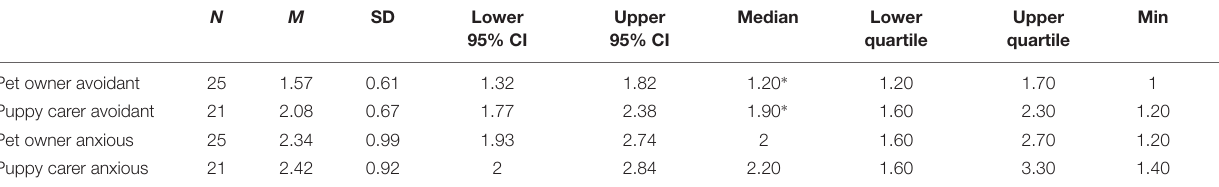
TABLE 14 | Avoidant and anxious attachment scores in pet owners and puppy